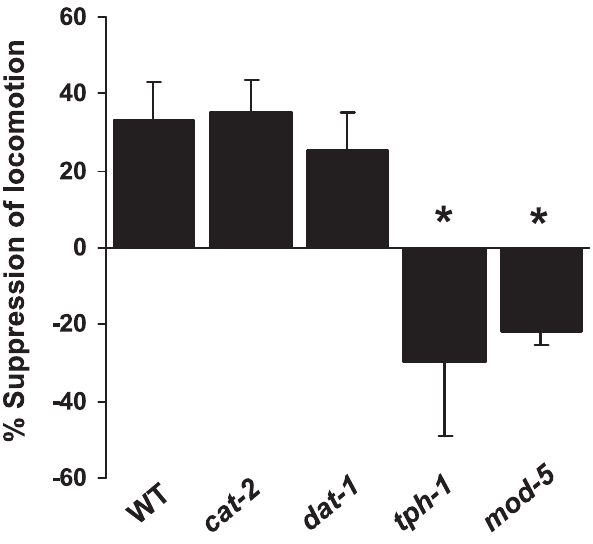
Figure 2. The cocaine-induced hypolocomotor response re- quires serotonin and/or dopamine. Data are quantified as percentage suppression of locomotion velocity between naı¨ve and cocaine-treated conditions for each genotype. *p , 0.01 (ANOVA with the Bonferroni test comparing mutants and WT). Error bars: SEM.